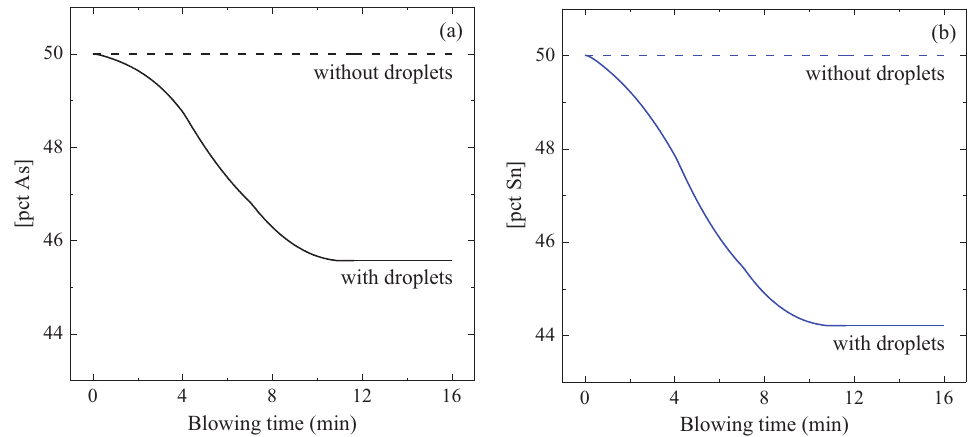
Figure 14. Model simulation results for the evaporation of ( a ) As and ( b ) Sn using the present model. Dashed and full lines are the evaporation results without and with the consideration of the ejected droplets, respectively. (color online) Shown by dashed lines and dotted lines in Figure 14 are the model calculation results assuming that (1) the evaporation only takes place at the bath (evaporation at the droplets is ignored), and (2) the evaporation takes place at both places (bath and droplets) but the temperature at the droplets was the same as that in the bath, respectively. Both